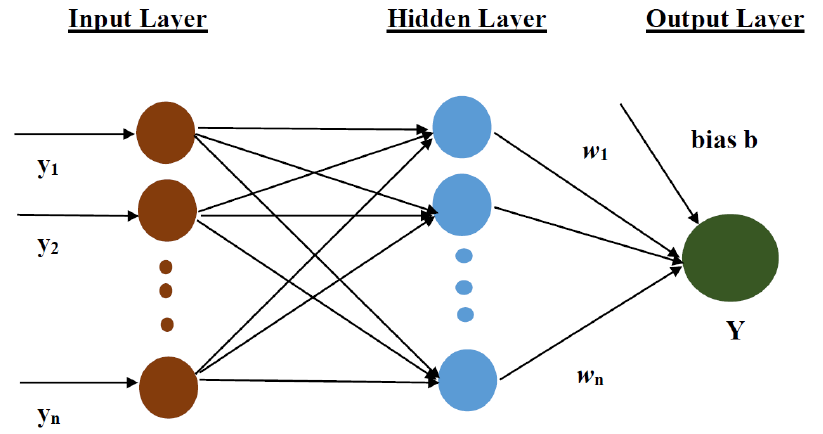
Figure 2. Model structure of the artificial neural network.